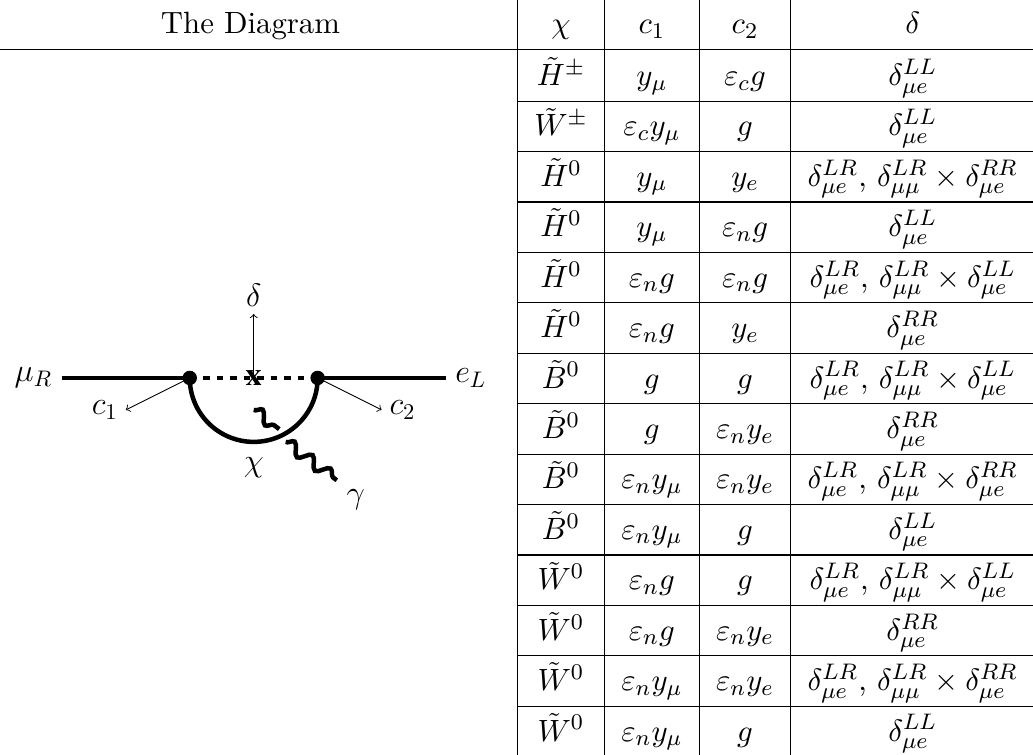
that come Table 4 . Diagrams with sleptons and gauginos/higgsinos in the loop contributing to c R 21 from the y term in eq. (A.2). This Wilson coefficient contributes to LFV observables such as L y R BR ( µ → eγ ) . The general topology of the diagram is shown on left. The second column shows the gaugino or the higgsino in the loop. The SM couplings appearing in each vertex, as well as ε s that characterize neutralino or chargino mixings, are shown in the next two columns. We consider all possible combinations of couplings with all possible fermions and sleptons in the loop. The last column includes the δ insertions on the slepton propagator. We are only including diagrams with the fewest number of δ insertions and at most one δ LR entry. These δ insertions are the source of LFV in our setup. As evident from the table, when ˜ m is not too large, i.e. δ LR is not too small, the diagram with a Bino in the loop and a chirality flip on the propagator dominates, while other diagrams have more suppression thanks to fermion mixings ε or the SM n/c